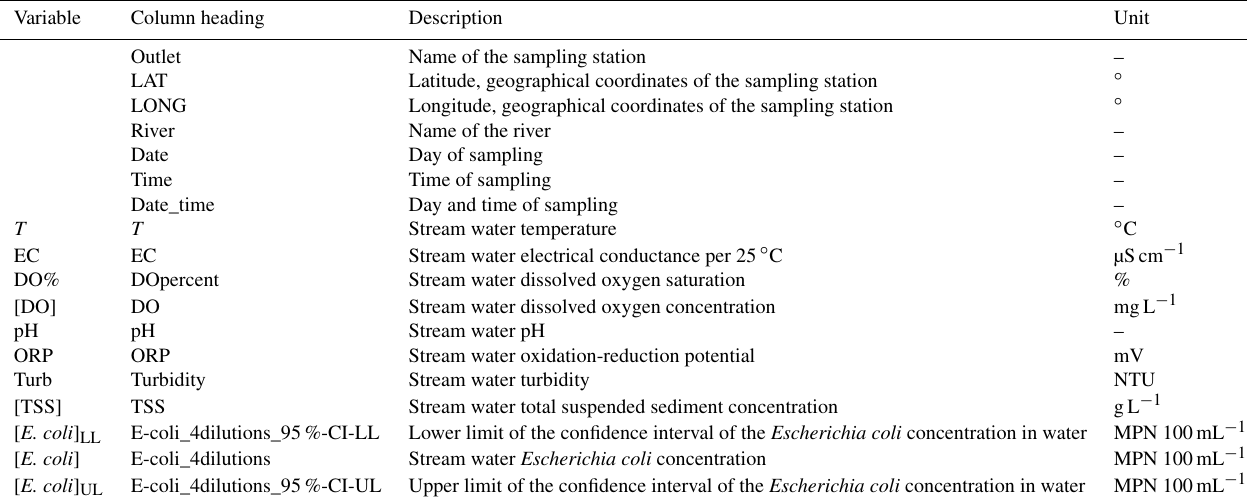
Table 2. Description of the 18 column headings of the database files along with variables units.